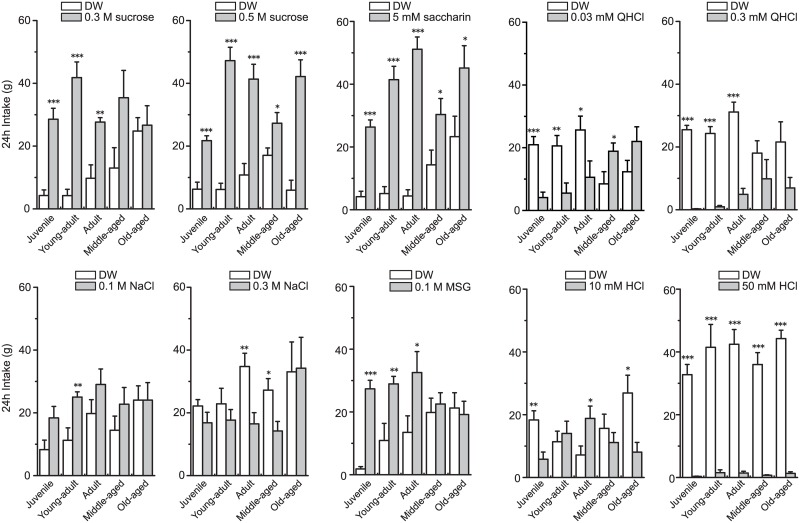
The 24-h intake for DW and each solution.Mean 24-h intake + SEM from the two-bottle preference test in which two solutions were presented simultaneously for 48 h. All asterisks indicate comparisons between the taste substance and DW. *P < 0.05, **P < 0.01, ***P < 0.01.